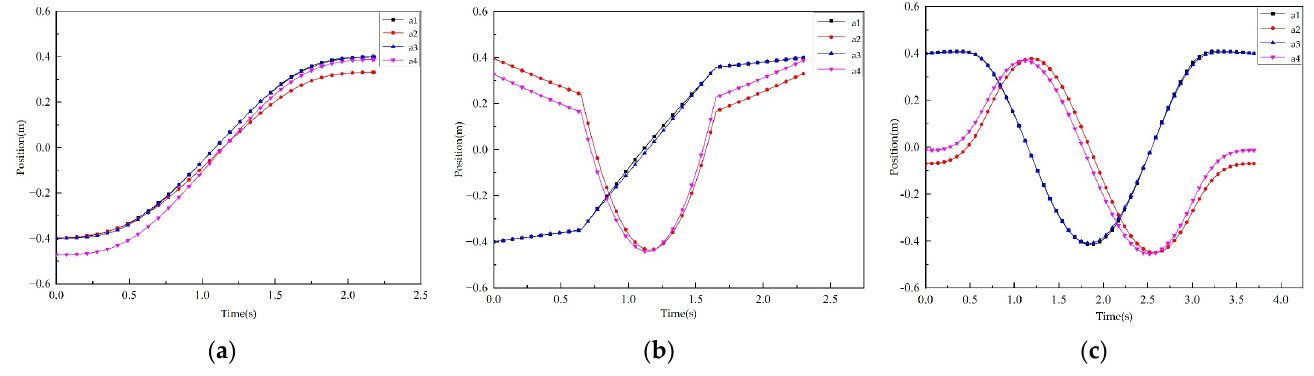
Figure 10. The trajectory planning curves of the exit point under ( a ) linear motion trajectory, ( b ) parabolic motion trajectory and ( c ) circular motion trajectory. ( b ) parabolic motion trajectory and ( c ) circular motion trajectory.